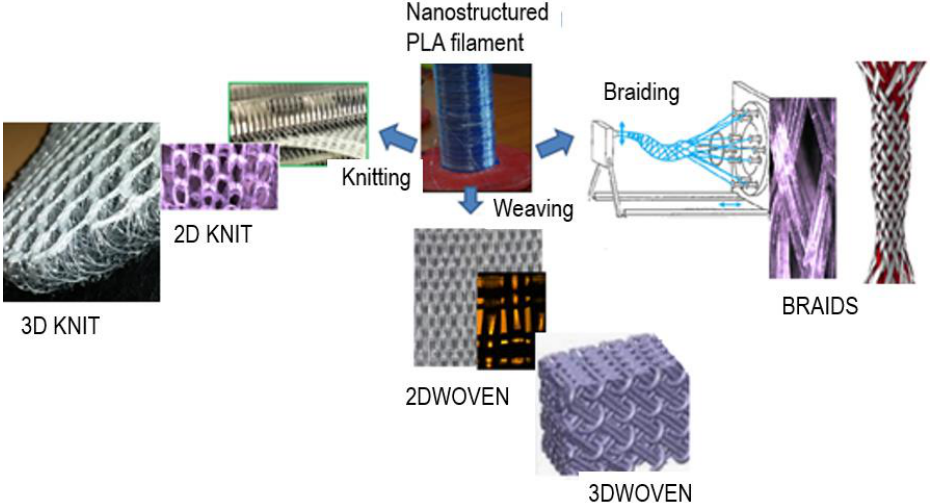
Figure 4. Processing ability of 100 µm and 230 µm diameter PLLA filaments into different 2D-3D structures (by weaving, knitting, and braiding). Minimum pore sizes ranged from 250 – 400 µm for the knitted scaffold, and from 50 – 100 µm for the woven, and 250 – 400 µm for the braids.